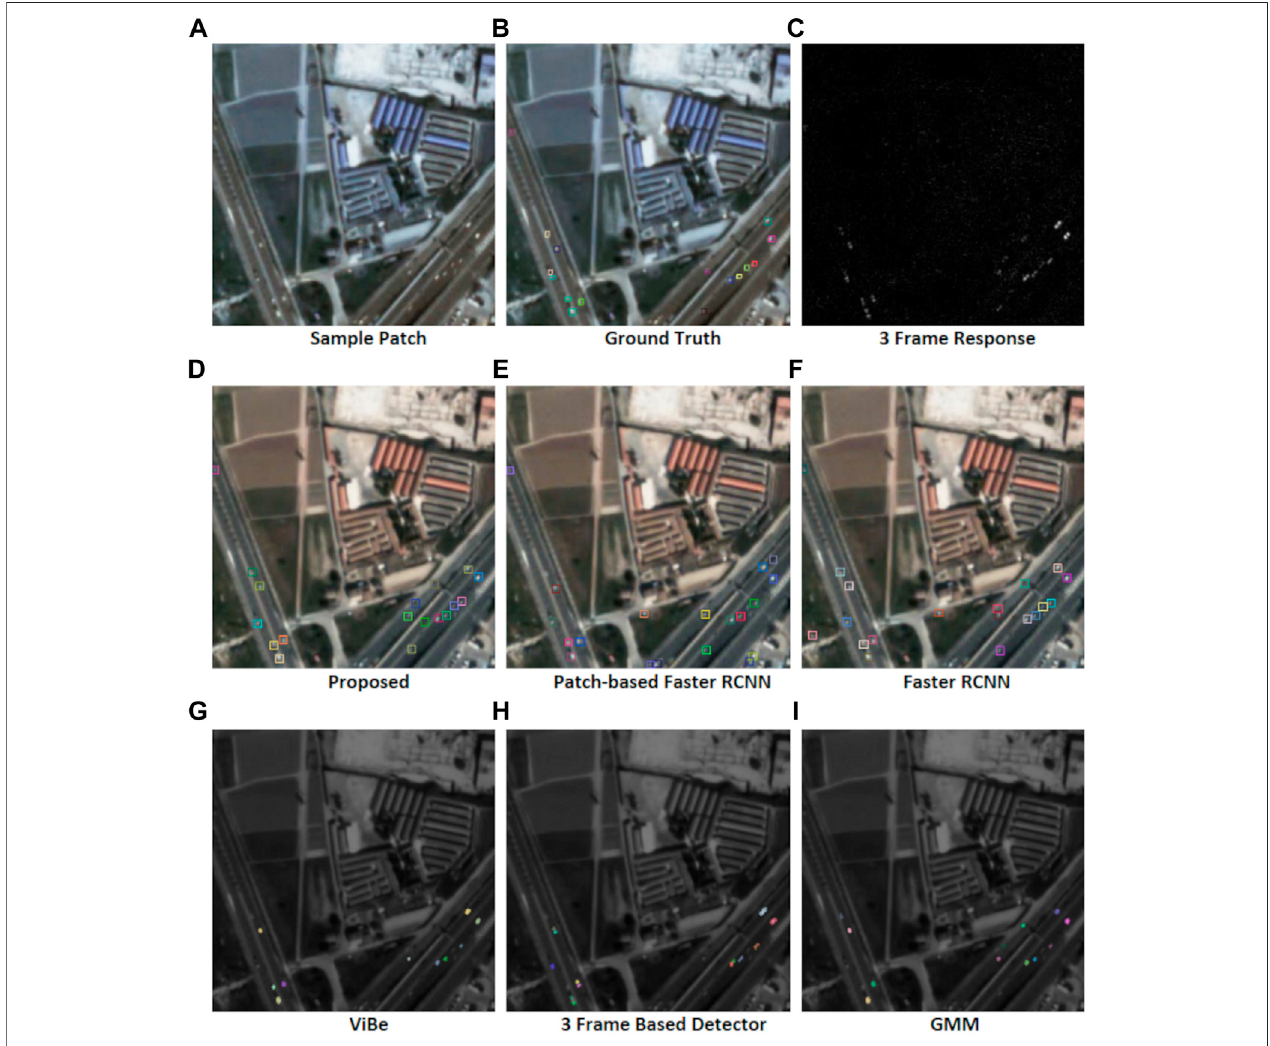
FIGURE 7 | Sample object detection in sub-region of AoI 2. First row: (A) sample patch . (B) Ground truth bounding boxes. (C) 3-frame difference response. Secondrow: (D) Proposed method. (E) Output ofpatched-based FasterRCNN. (F) Output ofFasterRCNN.Thirdrow: (G) Output ofViBe. (H) Output of3framebased detector. (I) Output of GMM